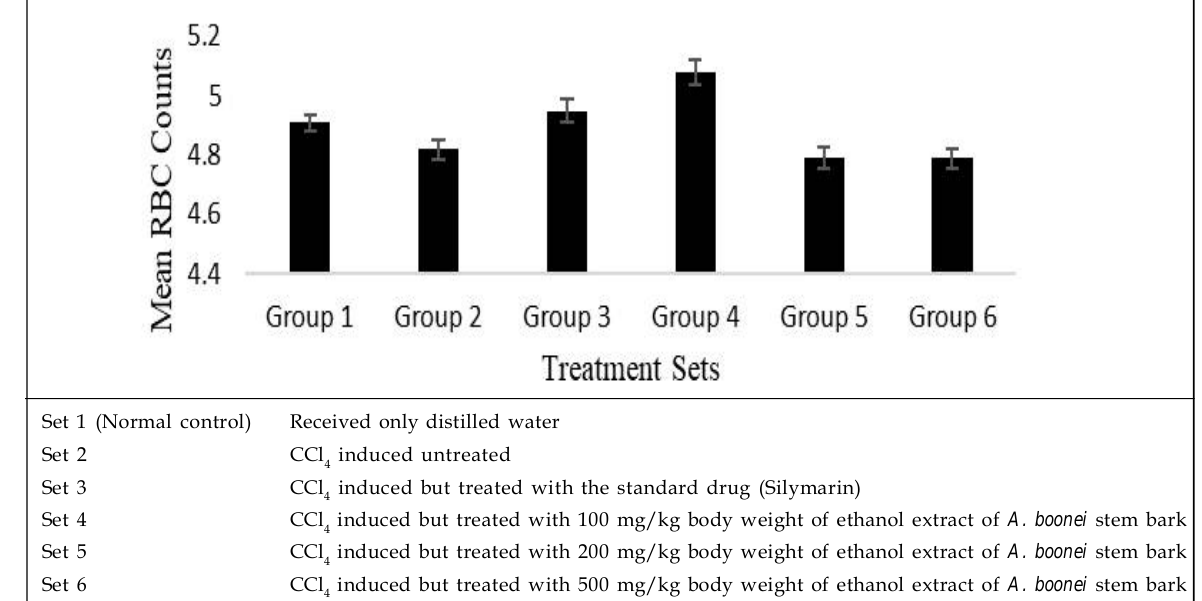
Figure 8: Red Blood Cell (RBC) count of male Wistar albino rats treated with A. boonei stem bark extract